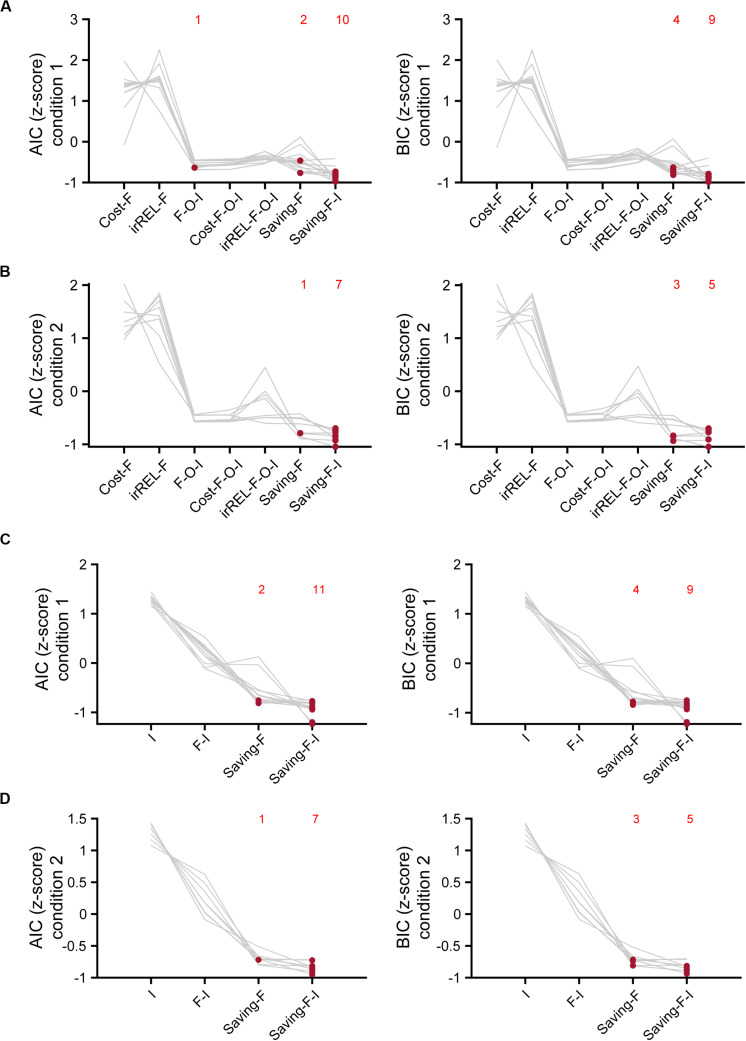
Model comparisons with AIC and BIC. (A,B) Z-scored AIC (left) and BIC (right) in cost-F, iREL-F, F-O-I, cost-F-O-I, iREL-F-O-I, saving-F, and saving-F-I models in conditions 1 (A) and 2 (B). (C,D) Z-scored AIC (left) and BIC (right) in I, F-I, saving-F, and saving-F-I models in conditions 1 (C) and 2 (D). Red dots indicate the model with the minimum score for each mouse. Each number indicates the number of the red dots in the corresponding model.